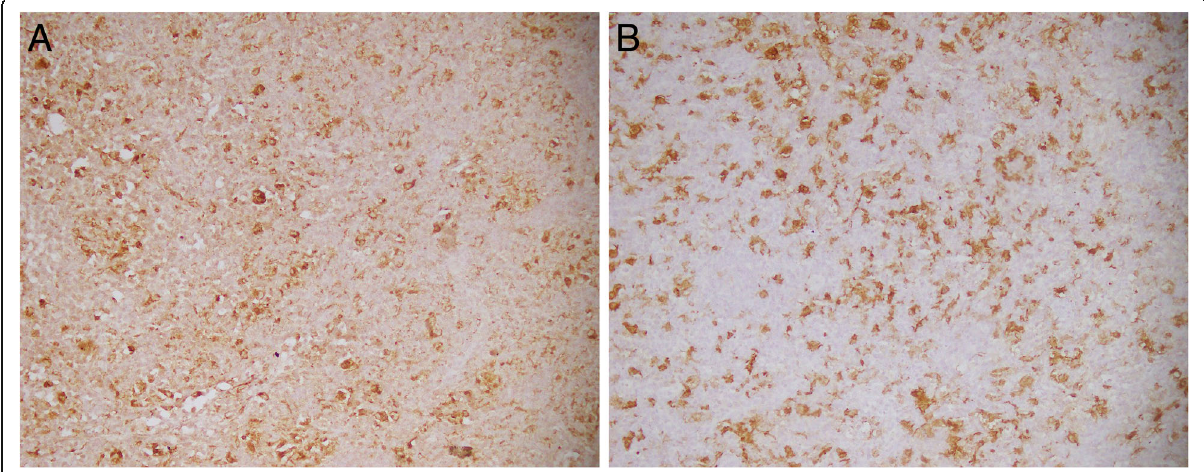
Fig. 3 a Immunohistochemical study for CD68 which is positive in histiocytes (× 200). b Immunohistochemical study for S100 which is positive in histiocytes (×